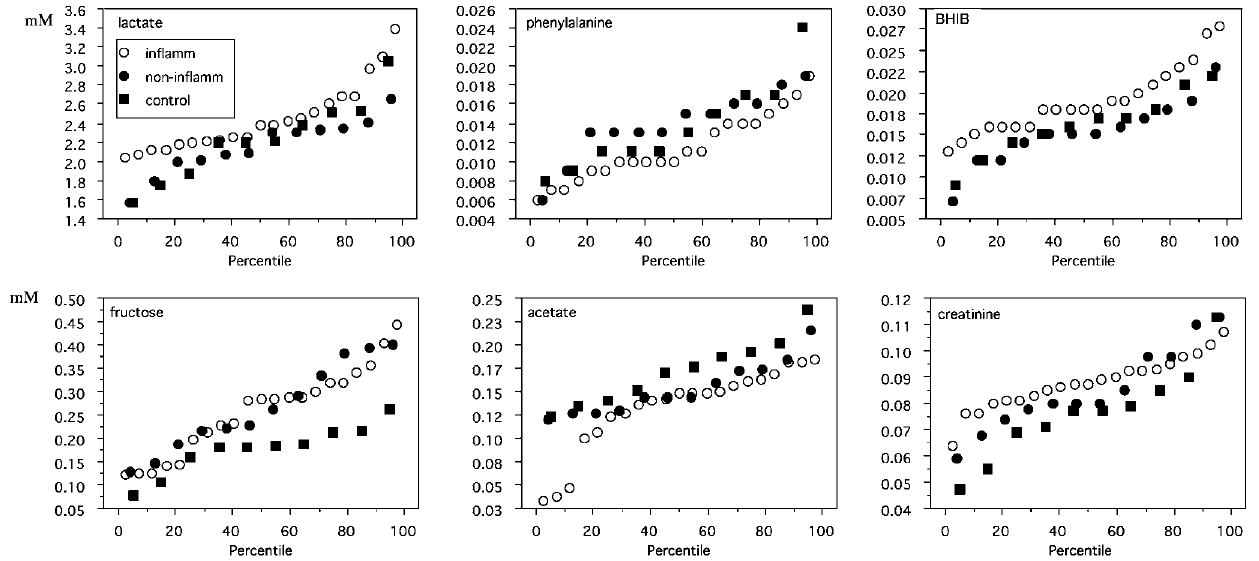
Figure 2. Percentile plots for selected CSF metabolite concentrations [mM] in patients with or without inflammatory brain MS plaques (abbreviated ‘inflamm’ and ‘non-inflamm’, respectively), and controls. These plots show the percentage of data less than or equal to an observed value. Marked deviations from normal distribution are readily recognized by major deviations from a straight line. The percentile plots for fructose illustrate the presence of CSF with particularly increased concentrations in CIS patients, independently of the presence of inflammatory plaques.